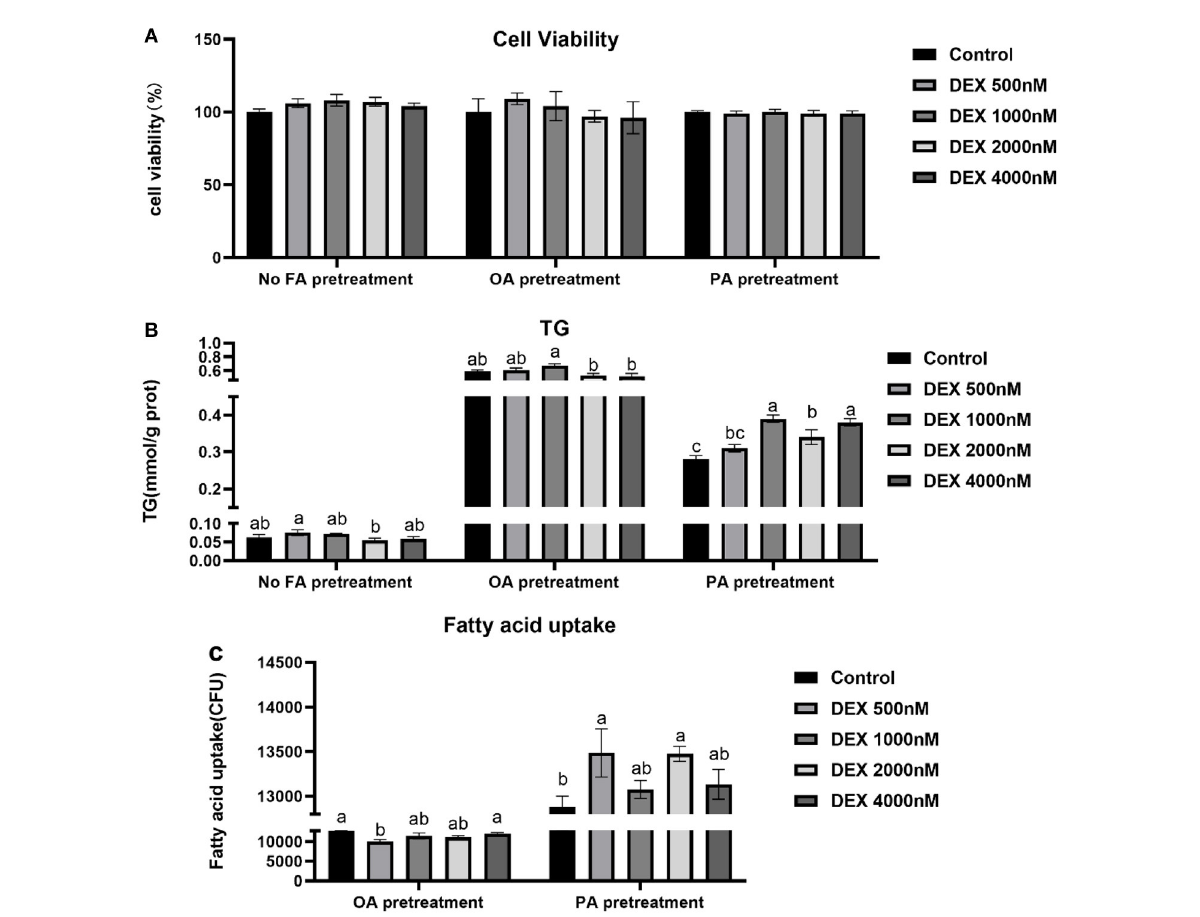
FIGURE3 Effects of dexamethasone on cell viability, triglyceride content, and fatty acid uptake in myoblasts pre-treated with different types of fatty acids or no FA pre-treatment. (A) Cell viability; (B) TG content; (C) Fatty acid uptake. Data are presented as the mean ± SEM ( n = 6). Different superscripts without common letters differ significantly ( P <